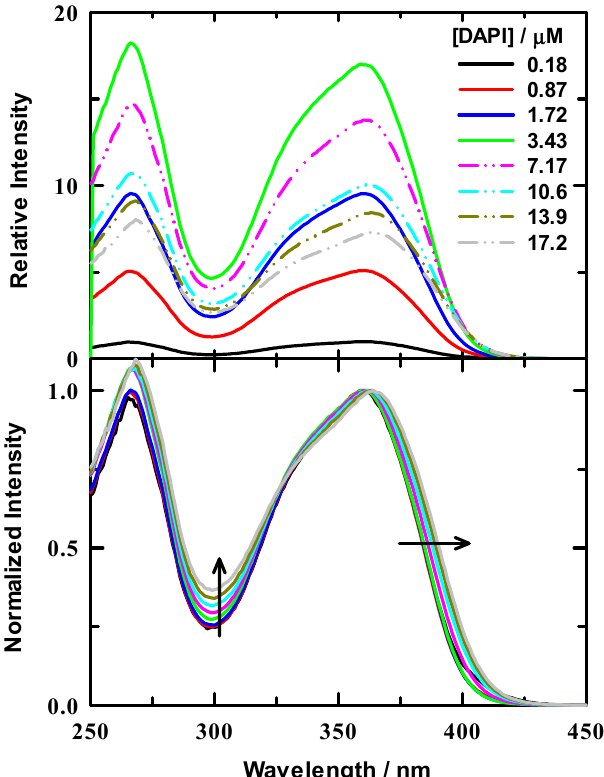
Figure 1. Excitation spectra for DAPI/DNA titration in 10 mM tris buffer at pH = 7.0. DNA concentration was 1.25 µ M. Upper panel: Relative intensities of example spectra for varied ratios that are all scaled relative to DAPI/tris buffer. The DAPI/buffer was normalized to 1. Lower panel: normalized spectra for all ratios to help visualize the relative spectral changes. Arrows indicate the direction of spectral change with increasing ratio.